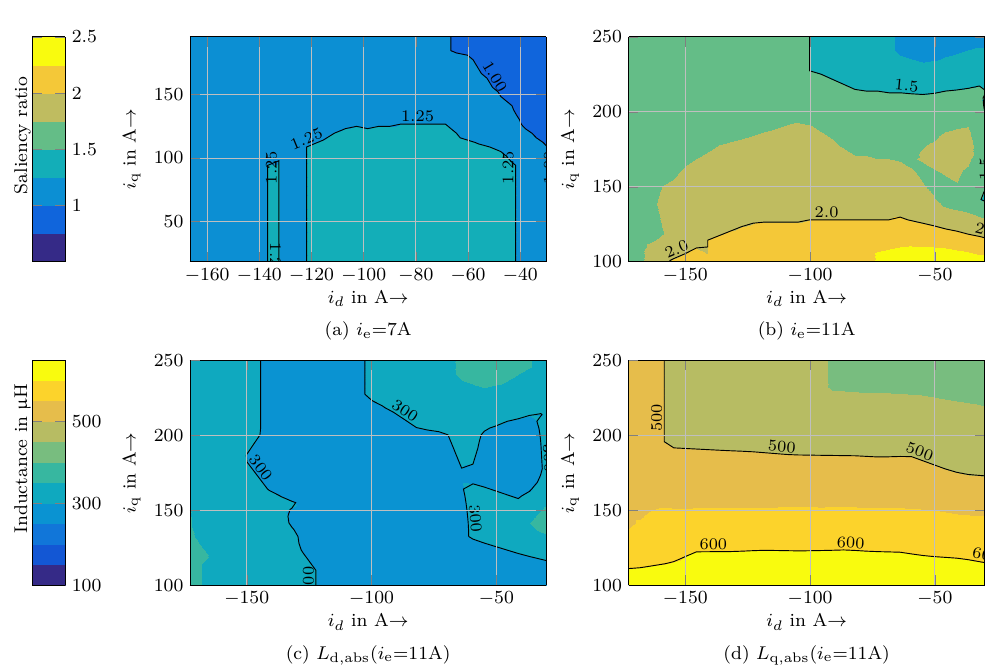
Figure 18. ( a , b ) Saliency ratio L q,abs / L inductances L d,abs and L q,abs for i e = 11